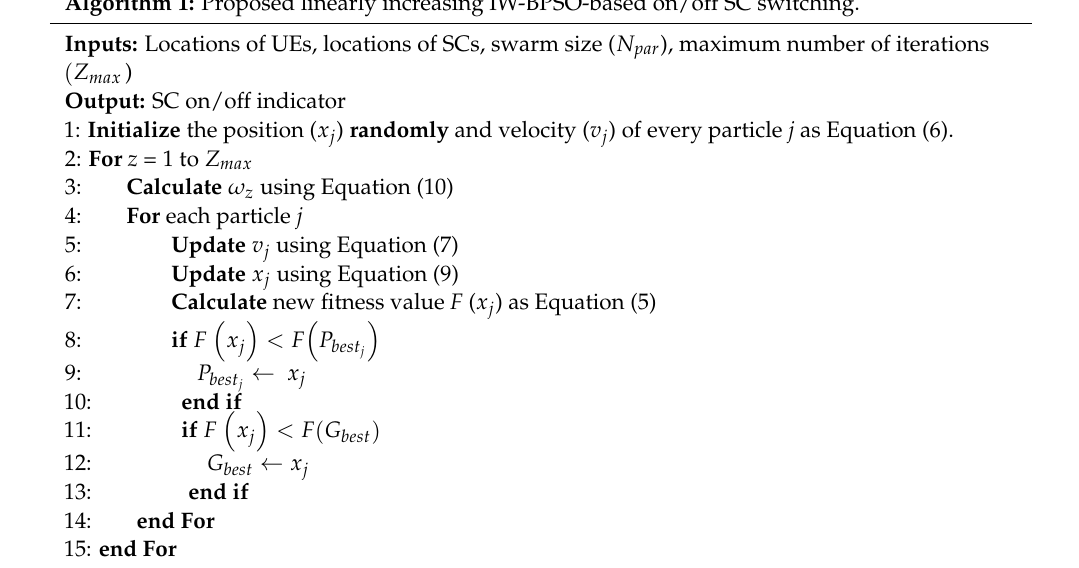
Algorithm 1: Proposed linearly increasing IW-BPSO-based on/off SC